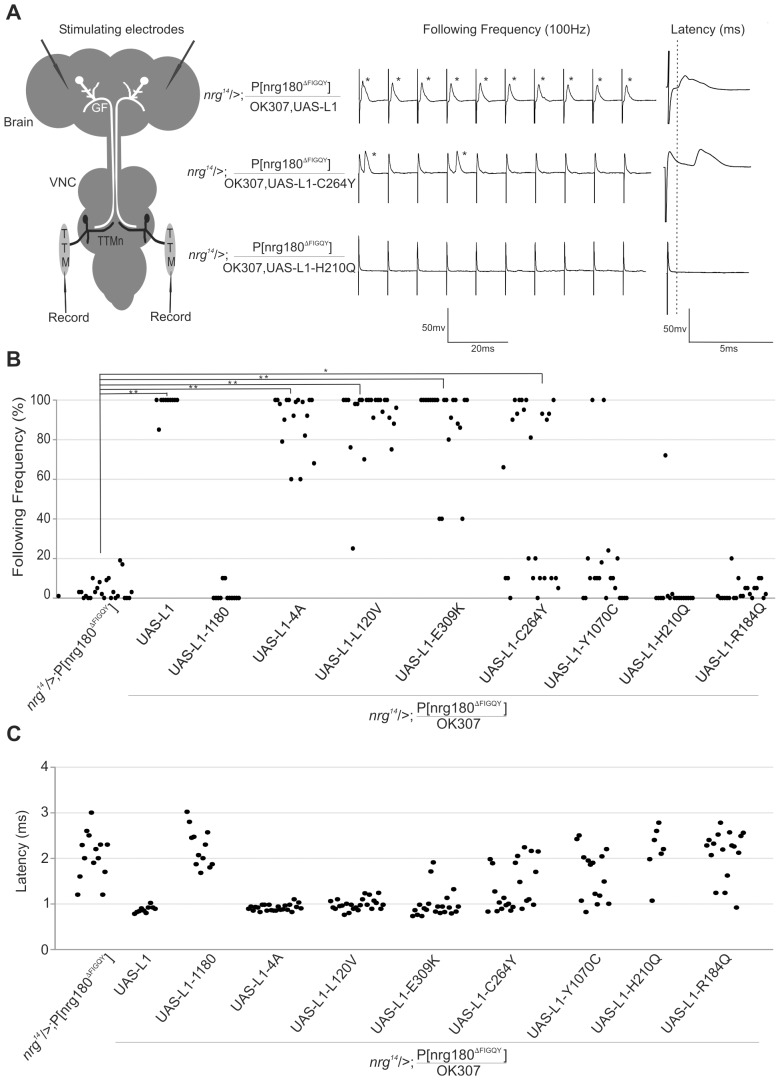
Functional characterization of GF-TTMn synaptic defects of mutant L1CAM protein expressions in nrg14;P[nrg180ΔFIGQY] background.(A) Schematic of the GF to TTM circuit in Drosophila. For electrophysiological recordings, tungsten electrodes were inserted into the brain for the GF stimulation. The output of the neuronal circuit was recorded from the TTM muscles with glass electrodes. Sample electrophysiological recordings from GF-TTM pathway. In positive control animals (nrg14/>;P[nrg180ΔFIGQY]/OK307,UAS-L1) the GF-TTM pathway was able to follow reliably at a one-to-one ratio when the GFs were stimulated in the brain with ten stimuli given at 100 Hz and the Response Latency was 0.87 ms (dashed grey line). In animals, which express L1-C264Y and L1-H210Q protein in a nrg14/>;P[nrg180ΔFIGQY] background, only few or no responses (asterisks) could be recorded when the GFs were stimulated in the brain. The Response Latency of all responses was increased. (B) Scatter plots of Following Frequencies. Following Frequencies were only significantly increased (** = p<0.001, * = p value ≤0.05, Mann-Whitney Rank Sum Test) in nrg14;P[nrg180ΔFIGQY] in animals that expressed UAS-L1, UAS-L1-E309K, UAS-L1-L120V and UAS-L1-4A driven by OK307. (C) Scatter plots of Response Latencies. In some animals no responses could be recorded from the TTM when the GF was stimulated in the brain (see Table 1) and thus were not included in the scatter plot. However, in most responding animals that had a decreased ability to follow at a one-to-one ratio at 100 Hz, the Response Latency was increased indicating a reduction in synaptic strength for the GF to TTMn connection.